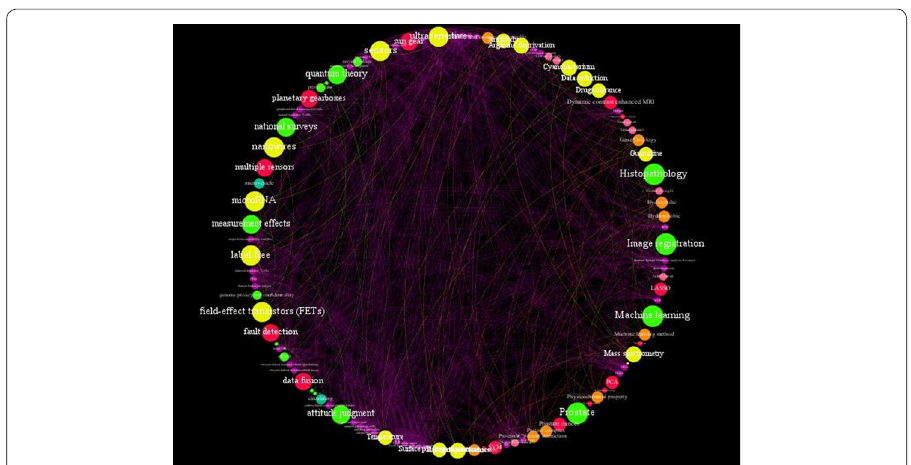
Fig. 15 Network of the co-occurrence of scientific keywords of the scholarly works cited by the patents